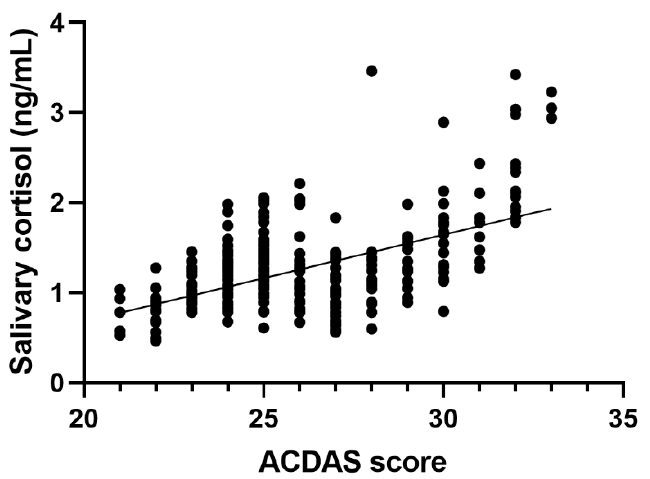
Figure 2. Correlation between ACDAS score and level of salivary cortisol (ng/mL).